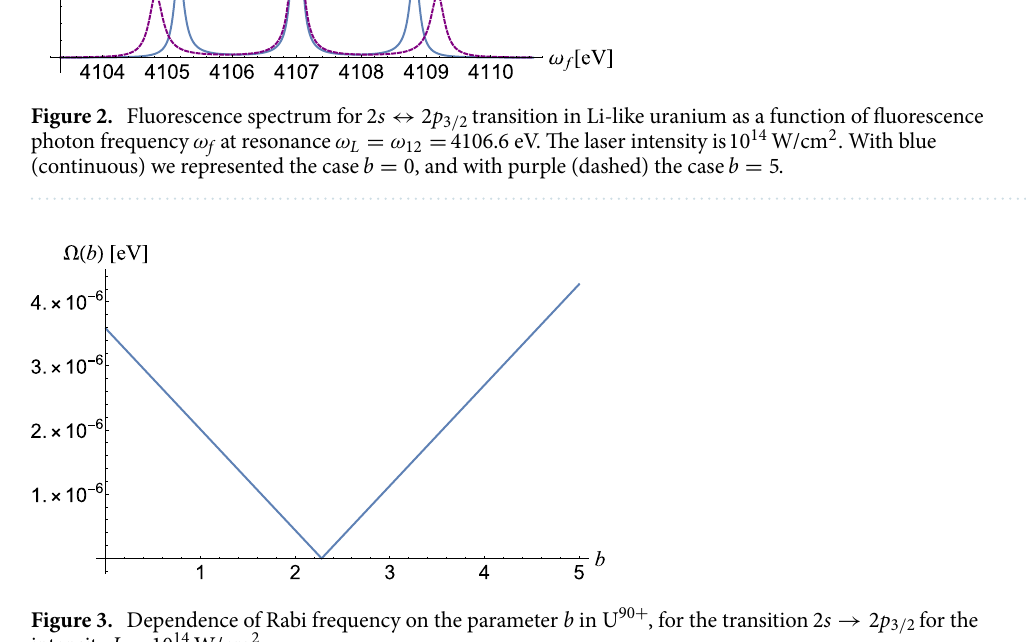
Figure 3. Dependence of Rabi frequency on the parameter b in U 90 + , for the transition 2 s 10 14 W/cm 2 intensity I =